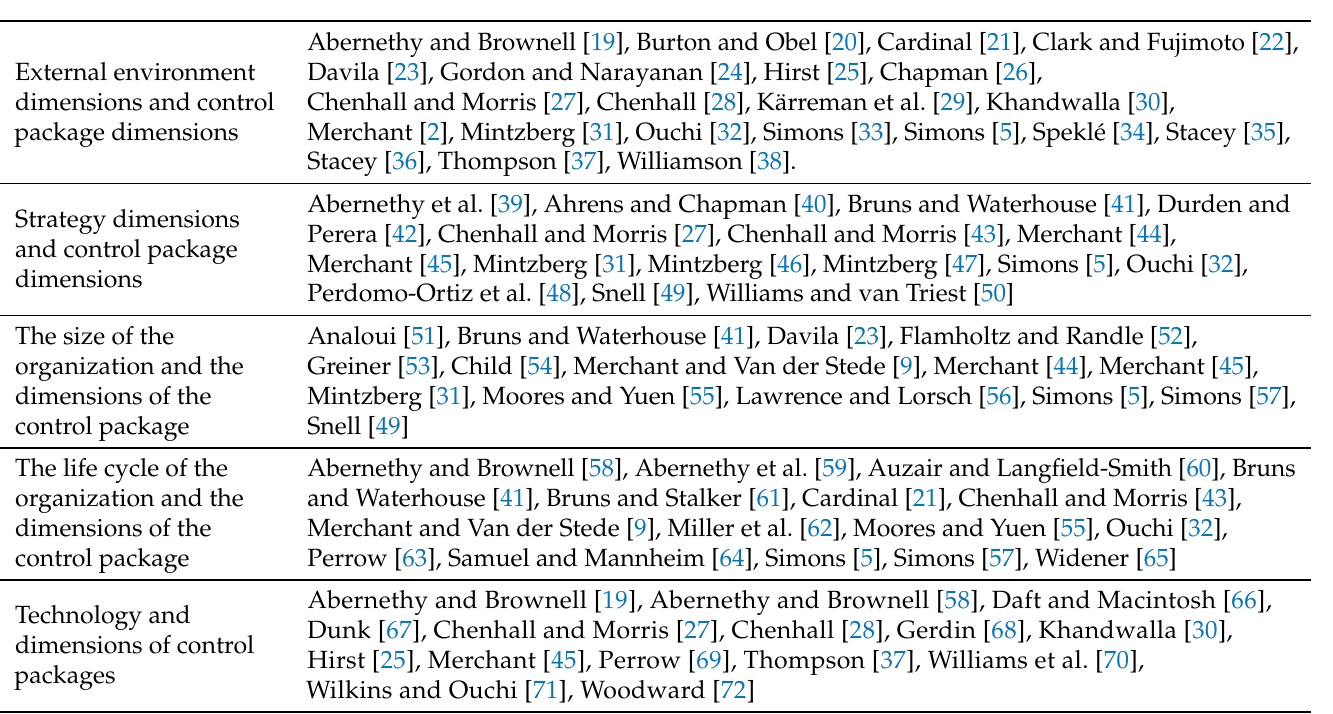
Table 1. Investigated studies in order to extract propositions about the relationships between control package dimensions and